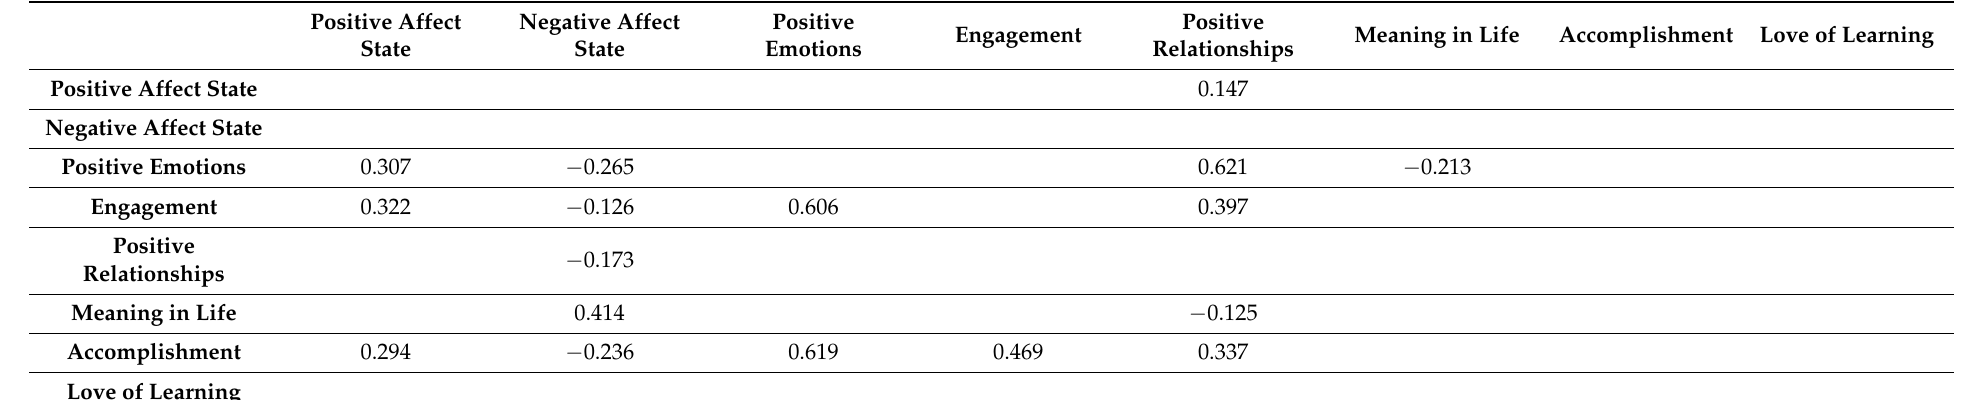
Table 6. Correlations between virtue of knowledge dimensions and subjective wellbeing